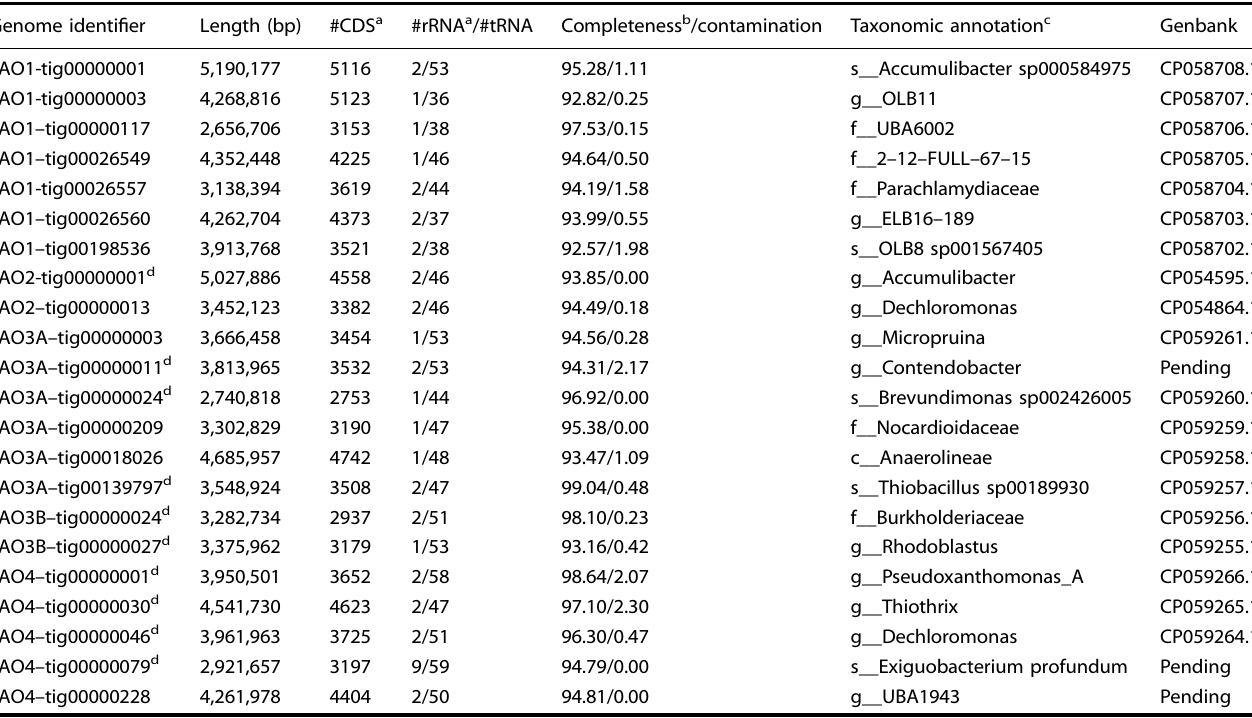
Table 1. Summary statistics for 22 putative genomes recovered in this